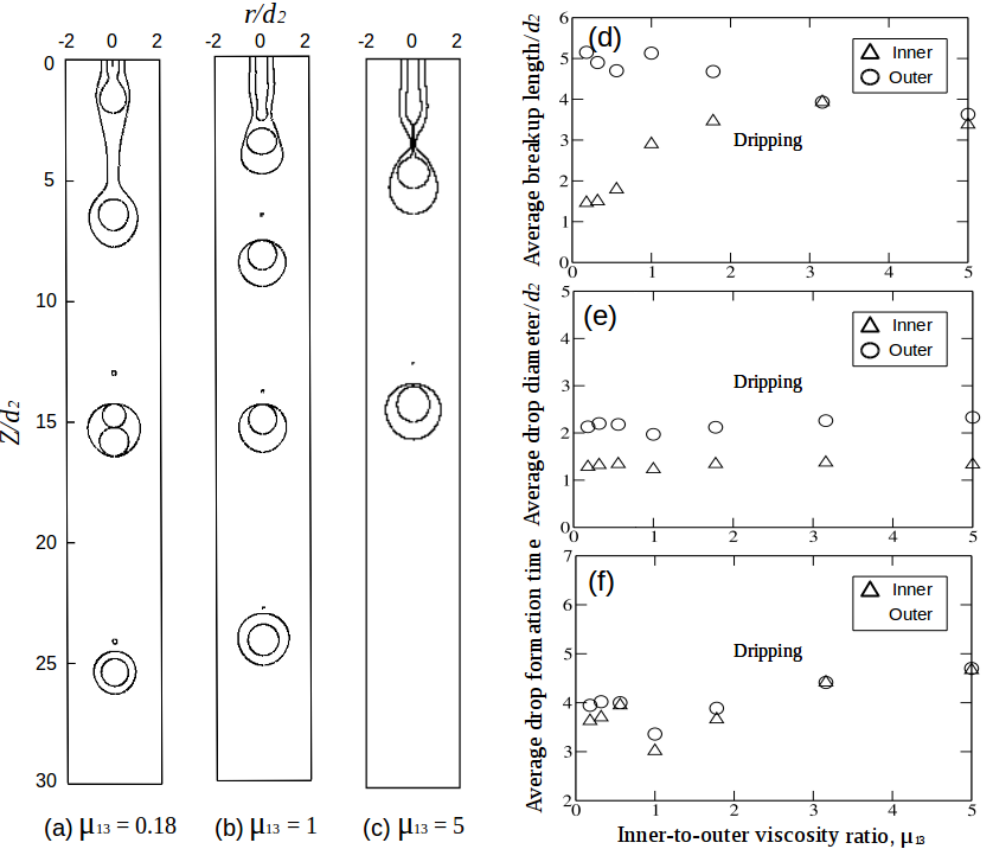
Figure 9. Snapshots of compound liquid jets for ( a ) µ 13 = 0.18; ( b ) µ 13 = 1 and ( c ) µ 13 = 5. The rest of the parameters are ρ 13 = 1, ρ 23 = 1 and µ 23 = 1. Graphs ( d – f ) represents the average breakup length, drop diameter and drop formation time for variable inner-to-outer viscosity ratios. Readers can refer to the Video “S3:Inner-to-outer Viscosity ratio” in the Supplementary Materials for better understanding of the multi-core drop formation process in the dripping